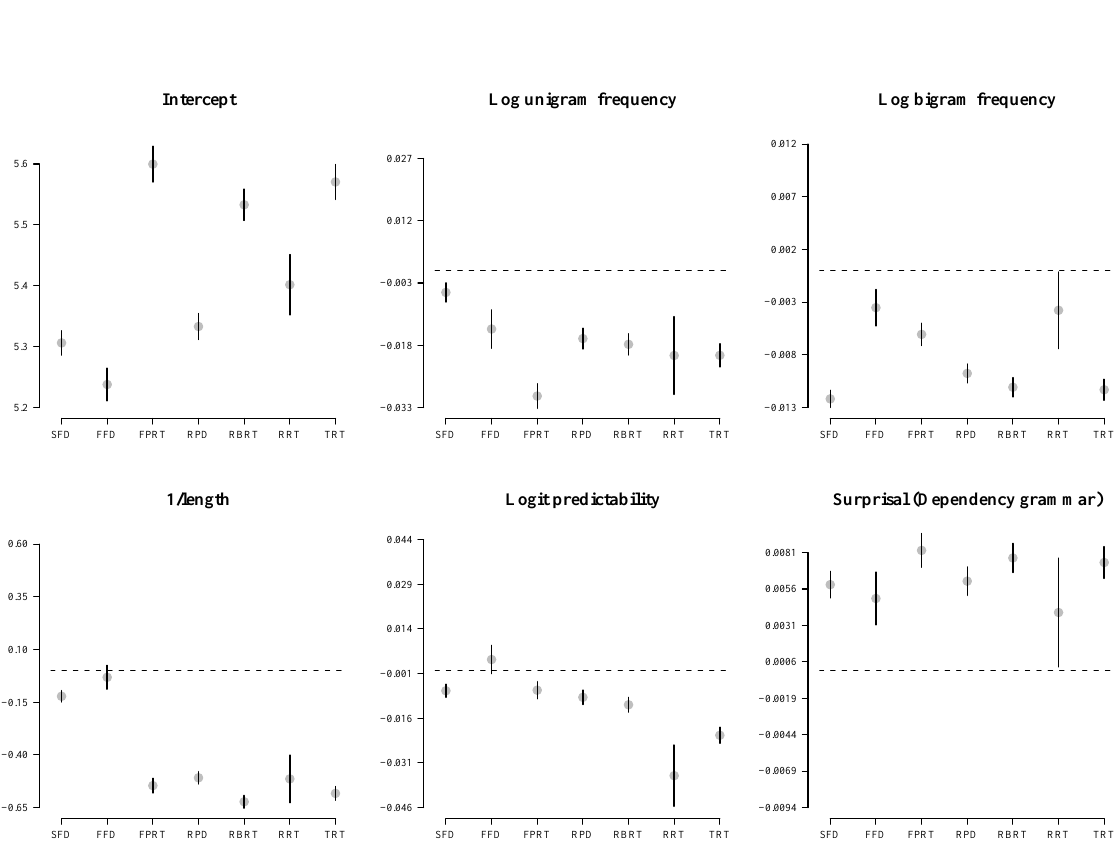
Figure 4 . Regression coefficients and 95% confidence intervals for the multiple regression using as predictors unigram and bigram frequency, 1/length, logit predictability and dependency grammar based surprisal. DOI